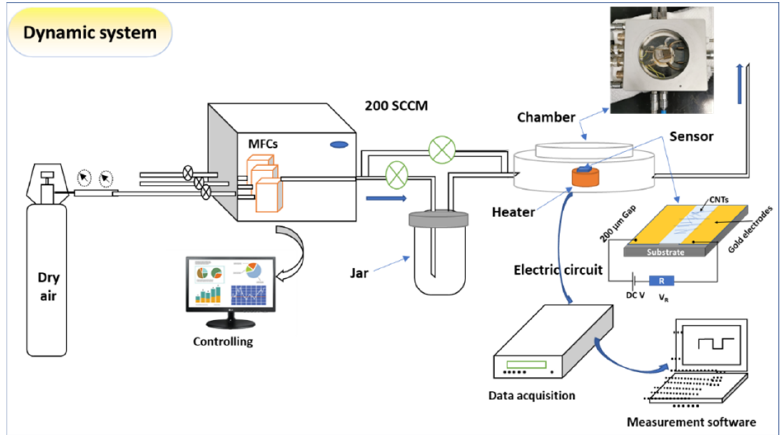
Figure 2. Scheme of gas sensing instrument, including MFCs, Linkam chamber attached with the heating system, electrical measurement, and sensor design.